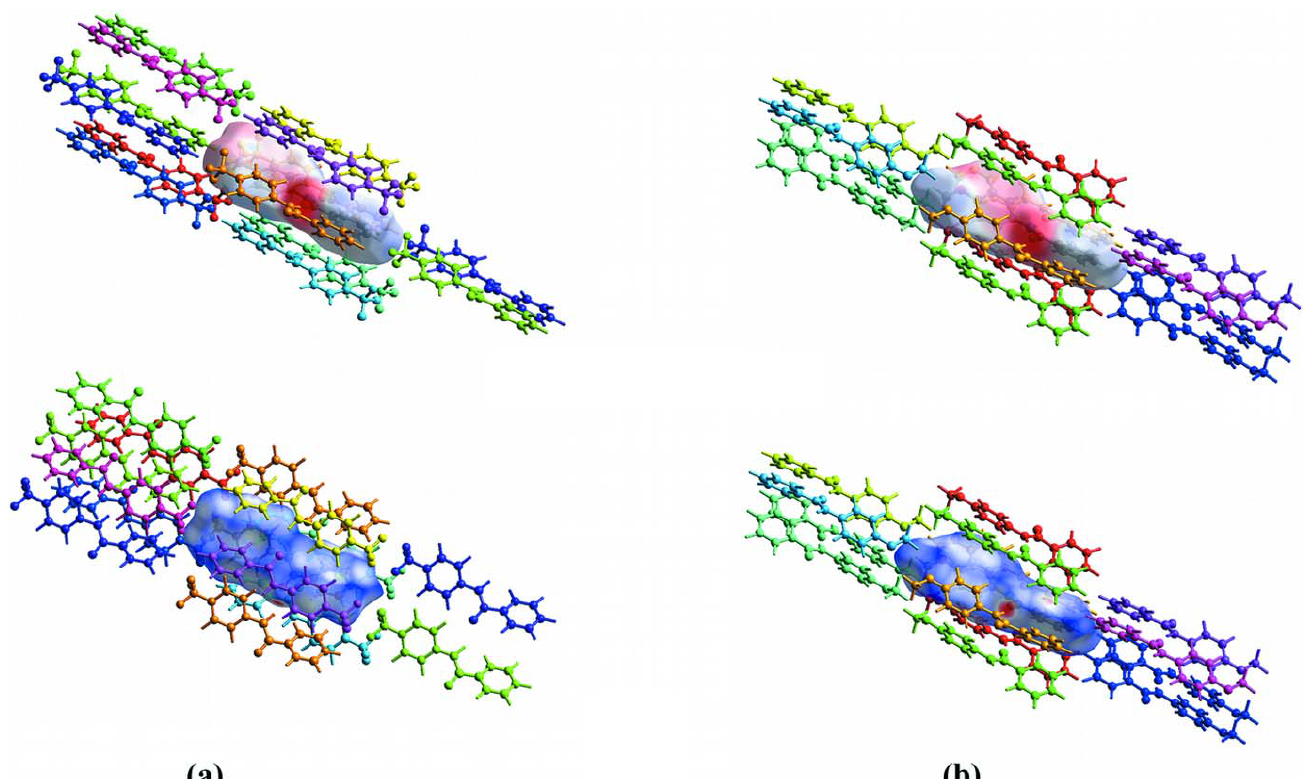
Figure 8 Intermolecular interaction energies and Hirshfeld surfaces with electrostatic potential (top) and d norm (bottom) plots are shown for ( a ) TFMP and ( b ) MOP . Scales for electrostatic potential are red ( (cid:5) 0.0788) to blue (0.1227) au for TFMP and red ( (cid:5) 0.0875) to blue (0.1219) au for MOP . Scales for d norm are red ( (cid:5) 0.2905) to blue (0.9711) for TFMP and red ( (cid:5) 0.3719) to blue (1.1524) for MOP . The color code for molecular interactions is shown in Fig.